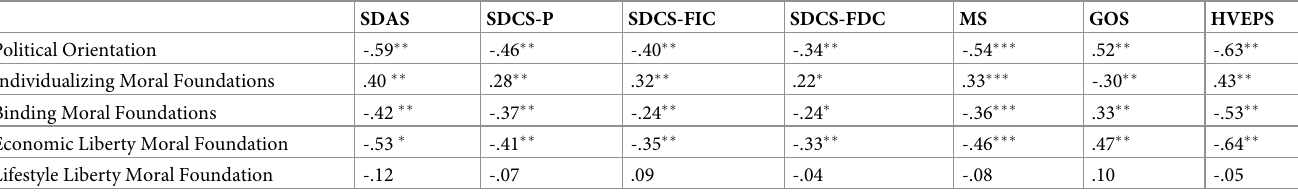
Table 6. Correlation matrix for political, moral, and social distancing outcome measures (n = 209).